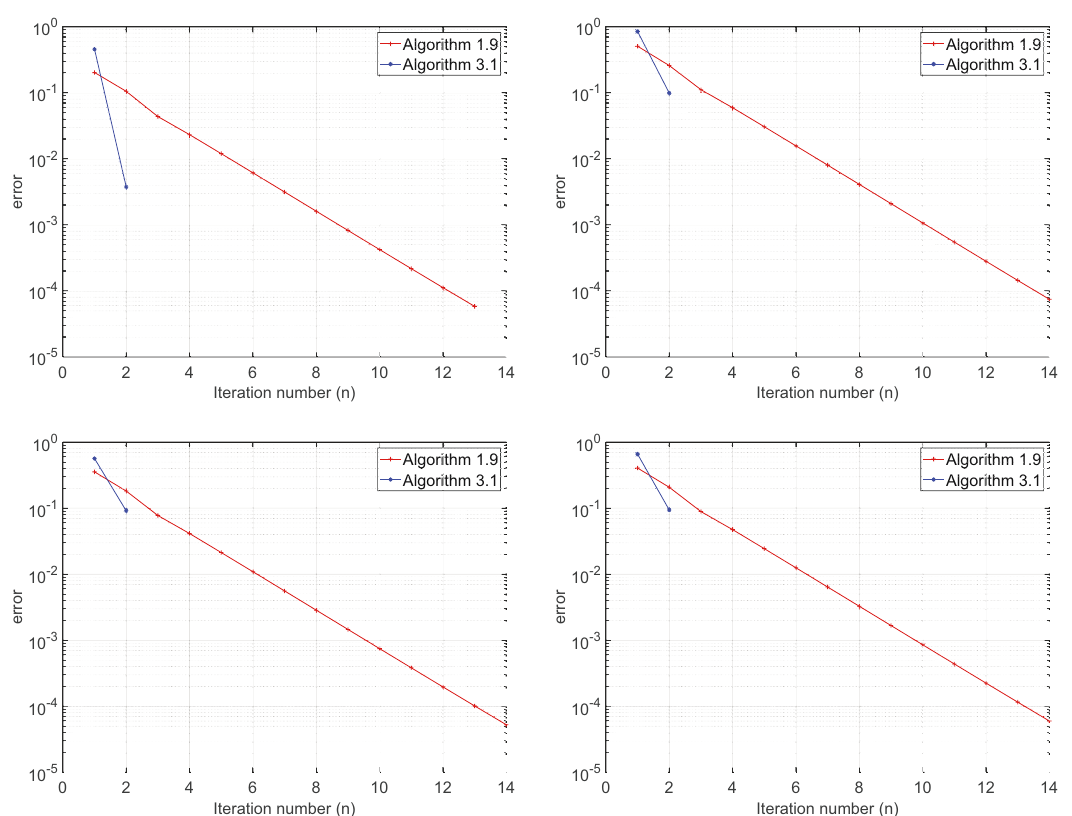
Algorithm 1.9 Algorithm 3.1